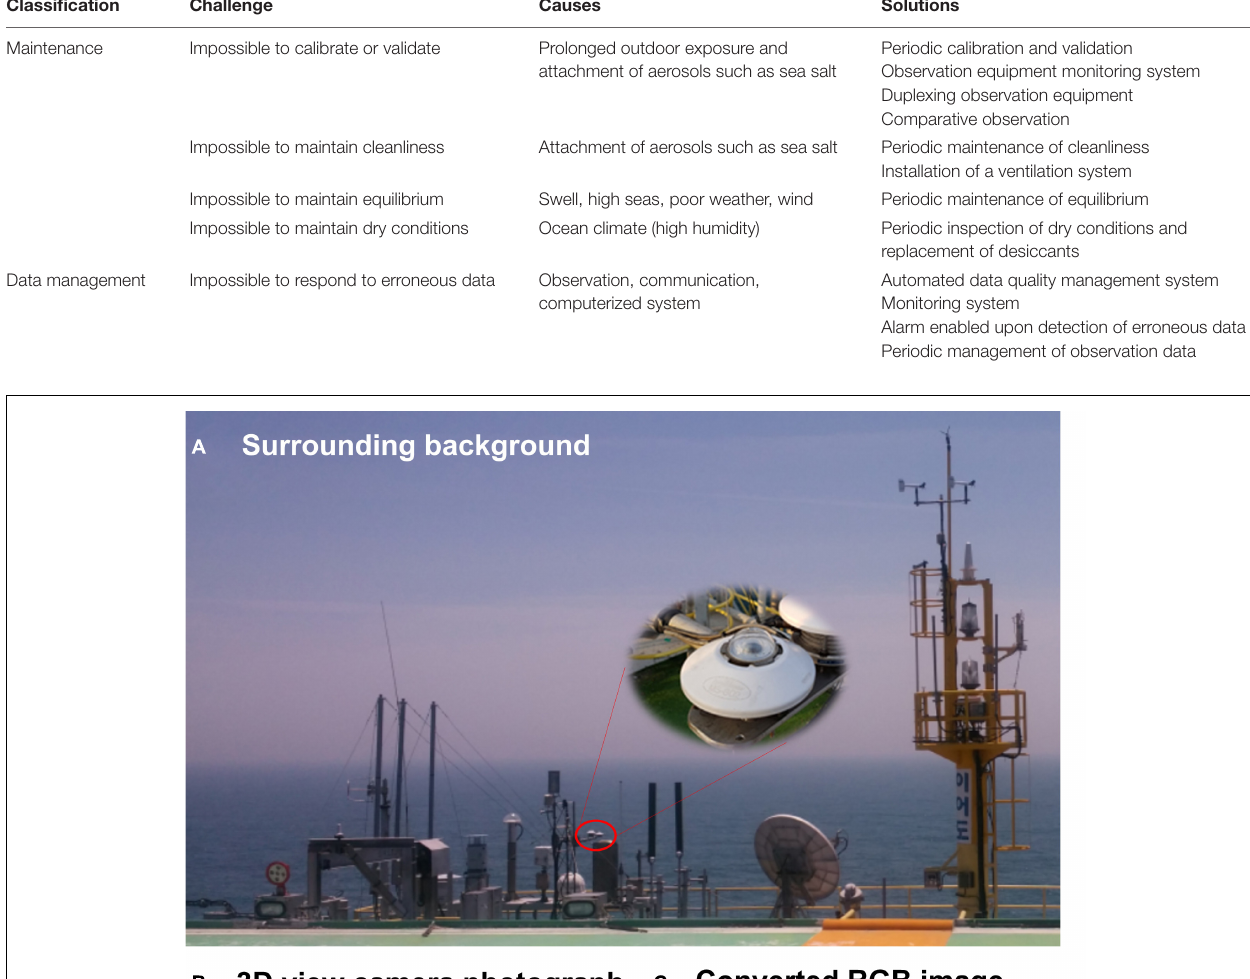
station, can obstruct the pyranometer’s field of view. In order